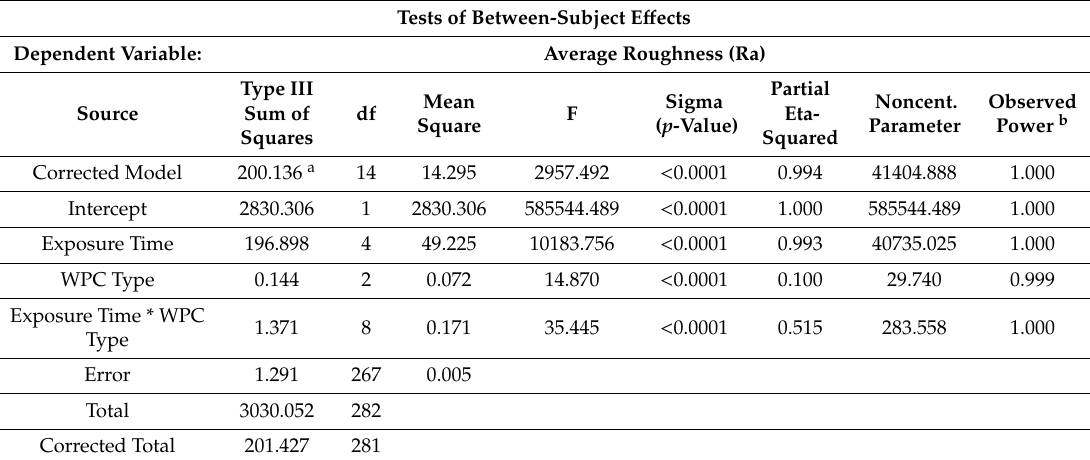
Table 3. Two-way ANOVA results for Surface Roughness (R a ), with wood plastic composite (WPC) samples based on their Type and Water Exposure Time as dependent